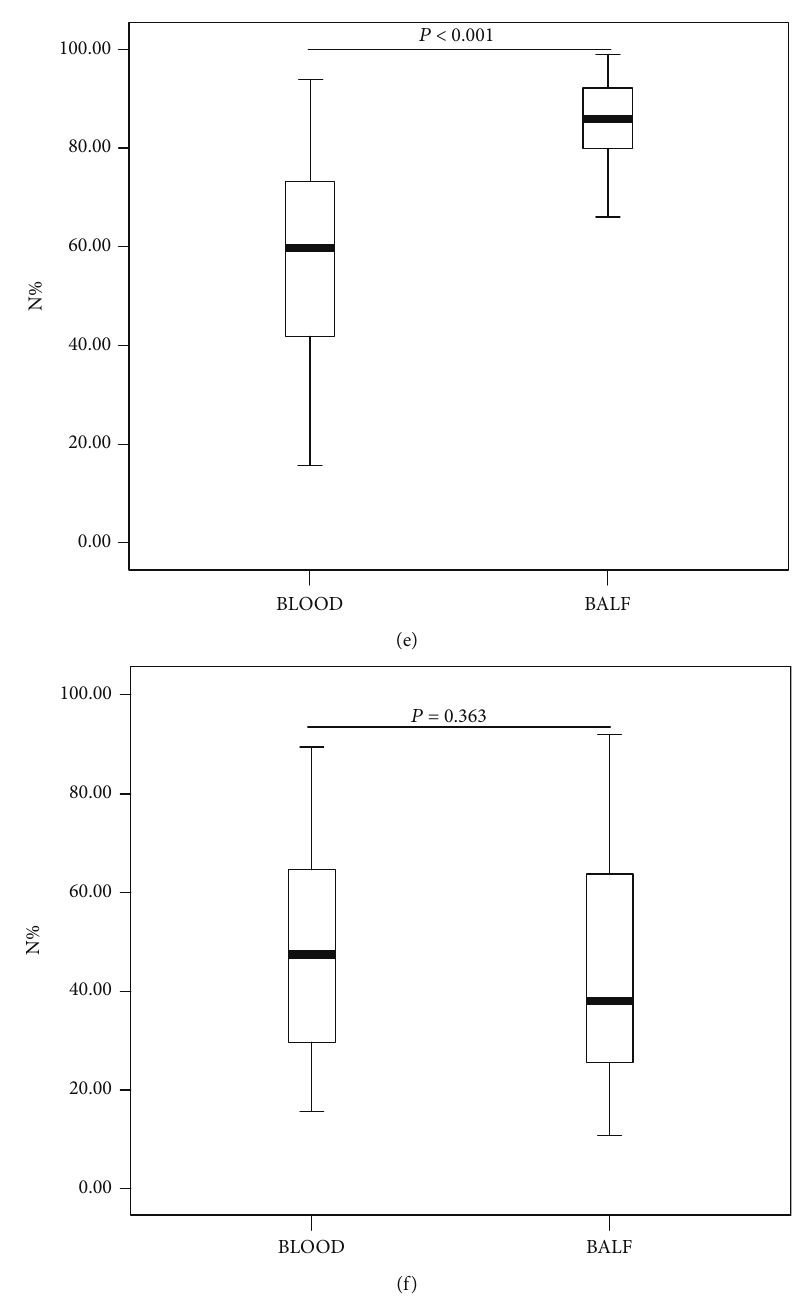
Figure 2: Blood and BALF HBP and IL-6 concentrations and N% in di ff erent patient groups. Blood and BALF HBP concentrations in patients with bacterial pneumonia (a) and with viral pneumonia (b), IL-6 concentrations in patients with bacterial pneumonia (c) and with viral pneumonia (d), N% in patients with bacterial pneumonia (e) and with viral pneumonia (f). HBP: heparin-binding protein; IL-6: interleukin-6; N%: neutrophil percentage; BALF: bronchoalveolar lavage fl uid. Error bars: 95.00% con fi dence